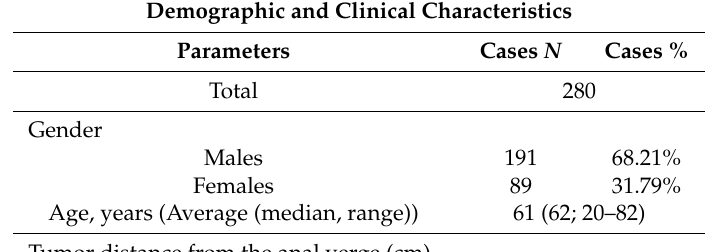
Table 1. Demographic and clinical characteristics of locally advanced rectal cancer (LARC) patients analyzed in this